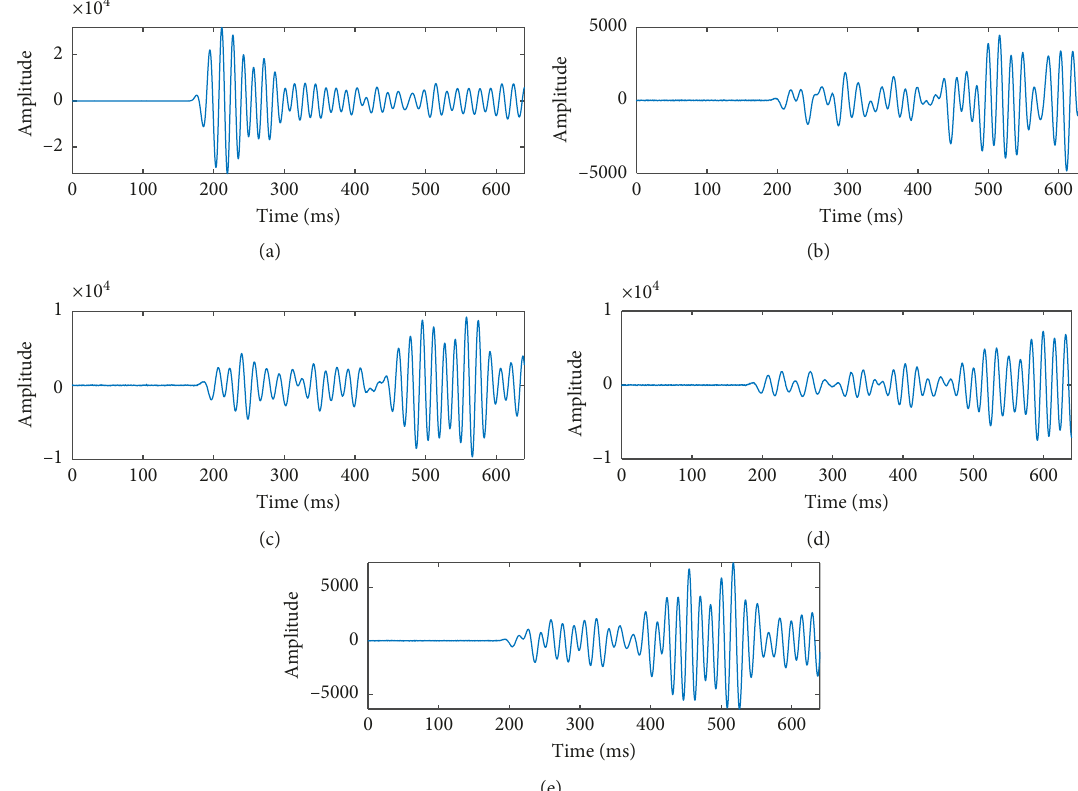
Figure 9: Time-domain ultrasonic signals in five cases: (a) intact concrete; (b) square hole depth 100mm; (c) square hole depth 200mm; (d) square hole depth 300mm; (e) square hole depth